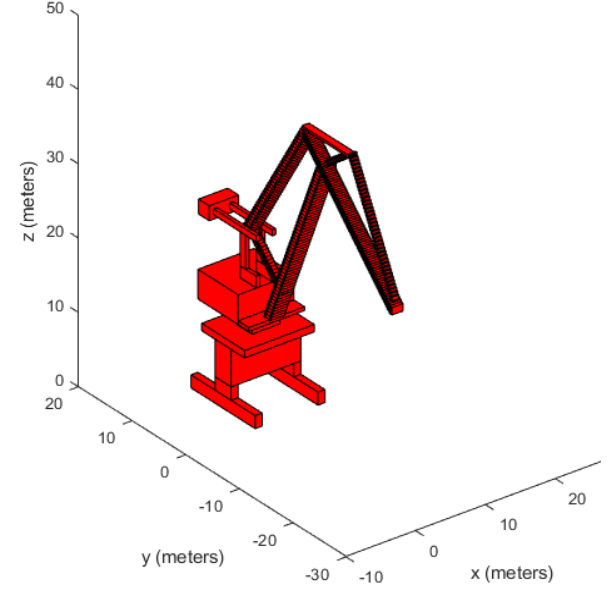
Figure 2. Simulation model of a gantry crane.